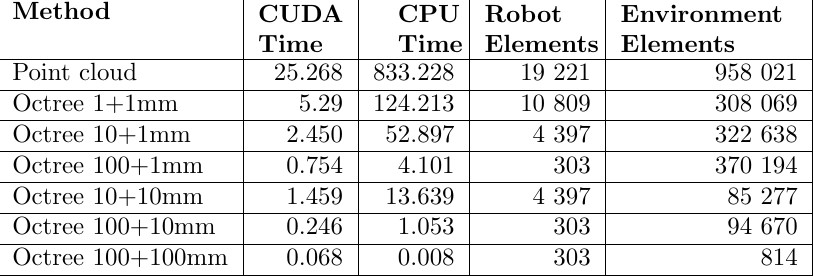
Table 2: Experimental results with a relatively large point cloud of